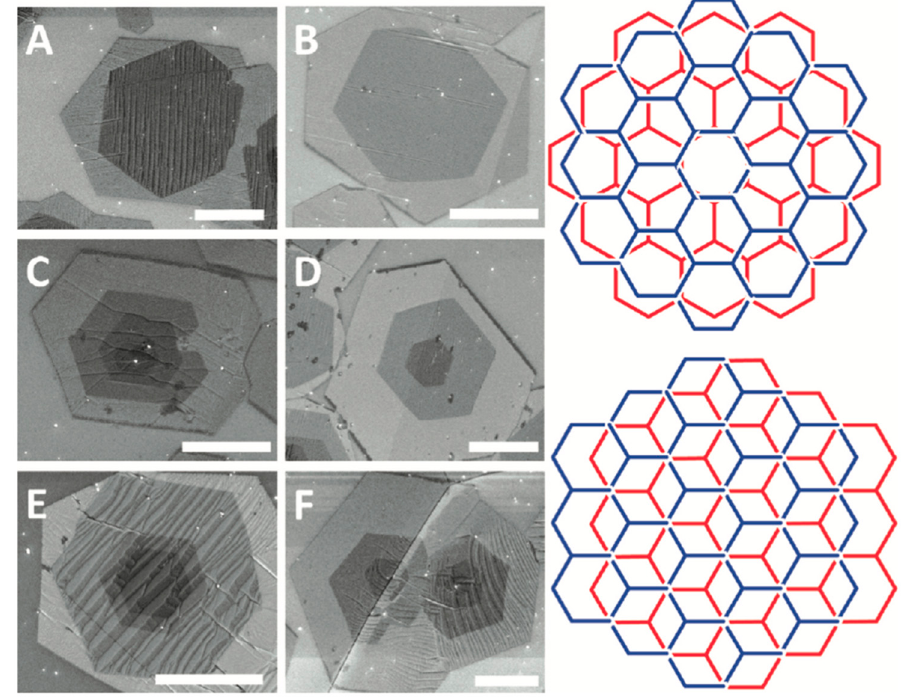
Figure 26. Analysis of mutual orientation between the layers in multi-layered graphene grown for 30 min at 60 ppm CH 4 , 19 Torr hydrogen pressure. All layers have hexagonal shapes in distinct contrast to irregular grains at higher methane concentrations. The second layer often appears misoriented with respect to the first layer, frequently showing 30 degrees rotation (right graphic) ( A , B , E ), while some do show what resembles AB Bernal stacking ( C , D ). The third and fourth layers, on the other hand, always show AB stacking ( C , F ). Scale bars are 3 µ m (reprinted with permission from [61]).